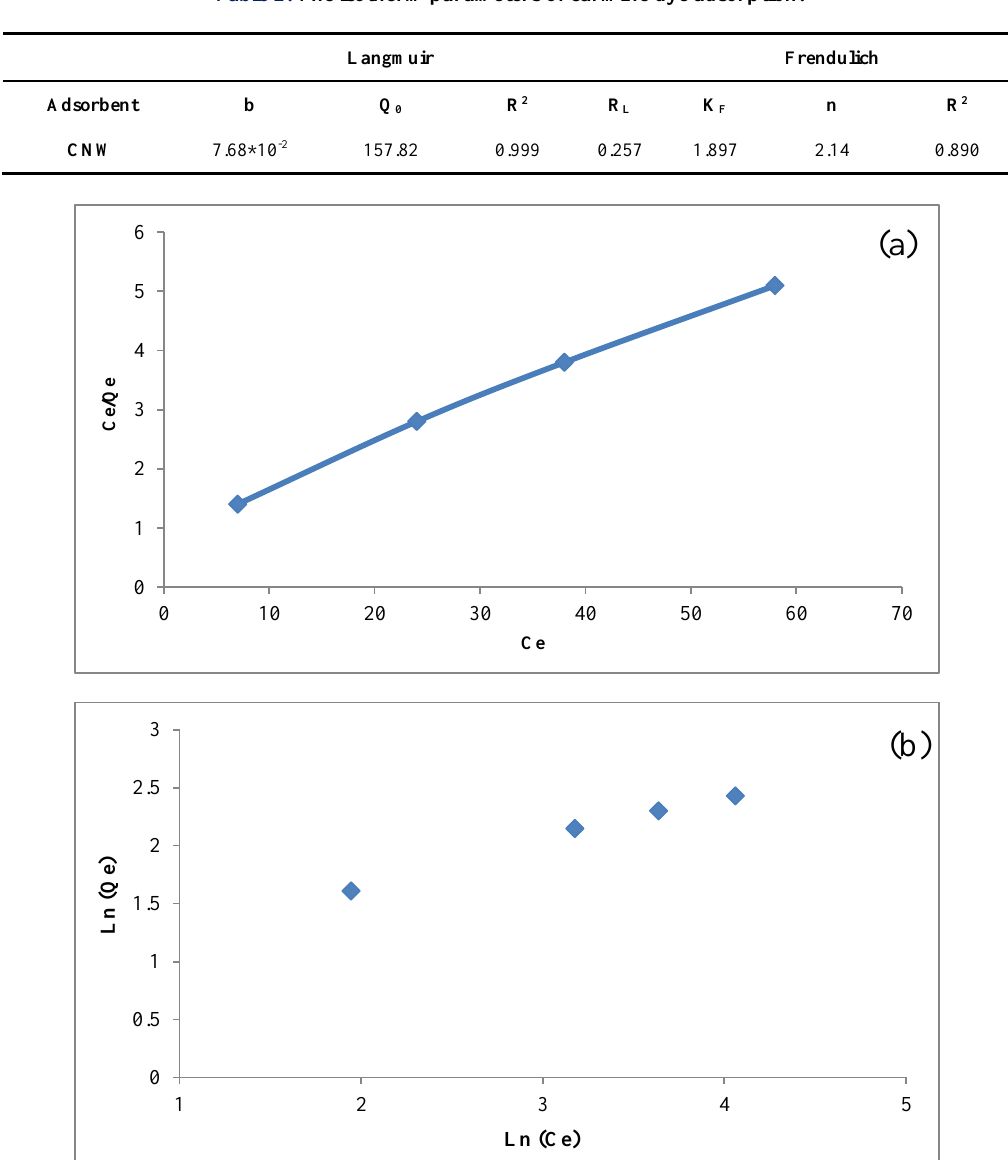
Figure 6. The isotherm data a) Langmuir; b)